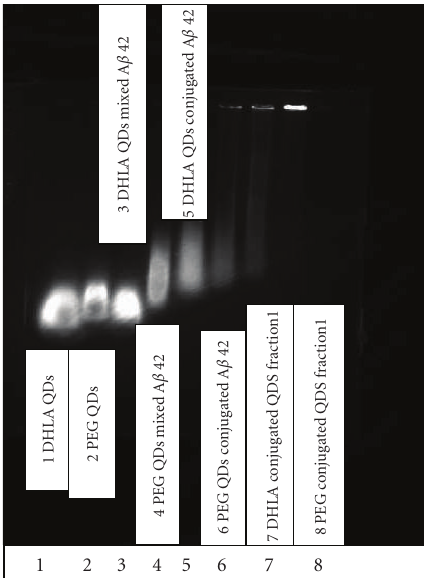
Figure 3: Gel electrophoresis image of DHLA-capped QDs (1) in comparison to DHLA-capped QDs mixed (3) and conjugated (5) to A β (1–42). PEG-capped QDs (2) in comparison to PEG- capped mixed (4) and conjugated (6) to A β (1–42). The purified fractions using gel chromatography for DHLA- and PEG-capped QDs conjugated to A β (1–42) are shown in wells 7 and 8,